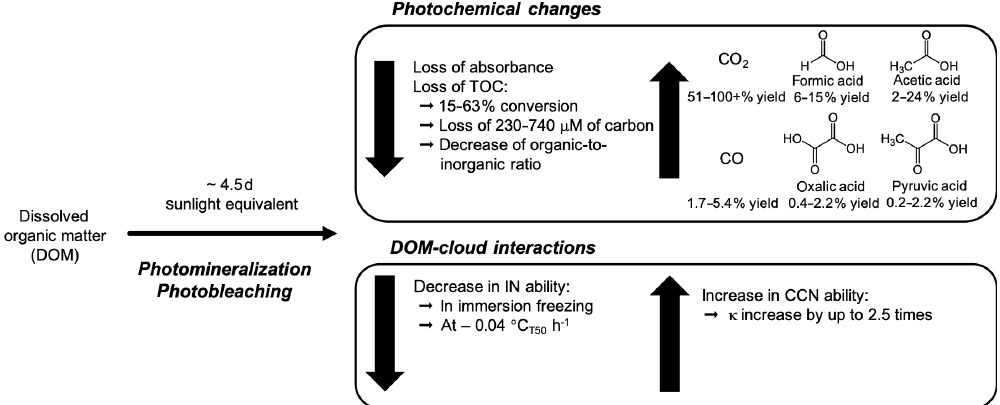
Figure 7. Overview of the impacts of the photomineralization mechanism on photochemical changes in DOM and on DOM–cloud interac- tions. After field-collected DOM and SRFA were exposed to the equivalent of 4.5d of sunlight, the TOC concentrations decreased between 15% and 63% conversion, while the production of CO, CO 2 and organic acids, including formic acid, acetic acid, oxalic acid and pyruvic acid, increased, with yields reported in molar carbon. In addition, the absorbance of the material decreased with photooxidation leading to photobleaching. These physicochemical changes are linked to a decrease in IN ability and an increase in CCN